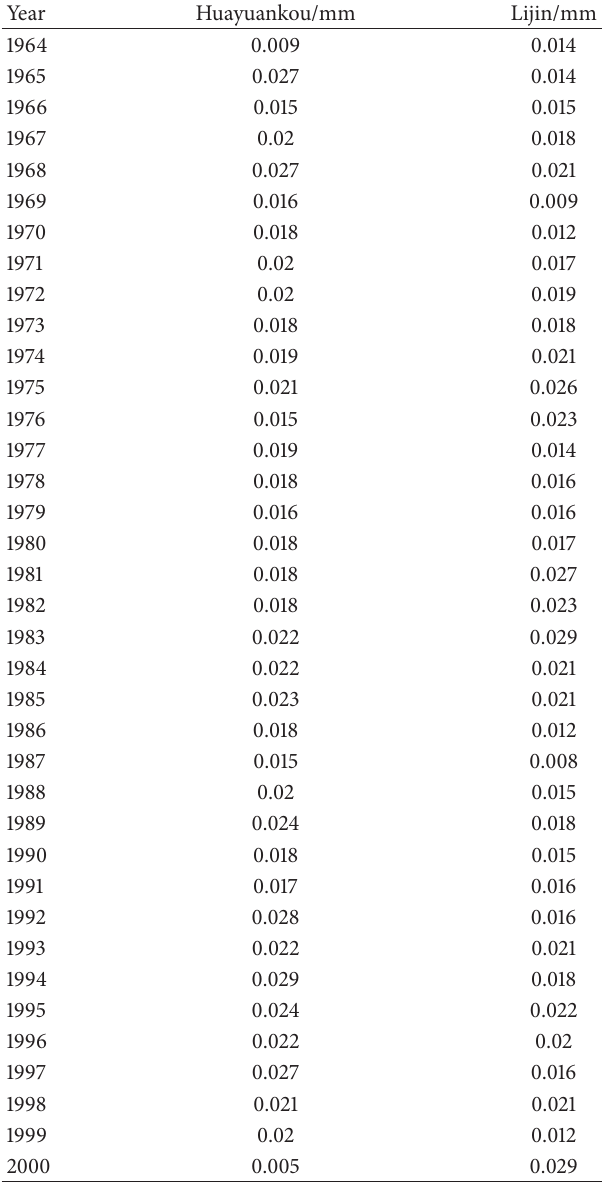
Table 3: Grain size of 𝐷 65 at Lijin and Huayuankou